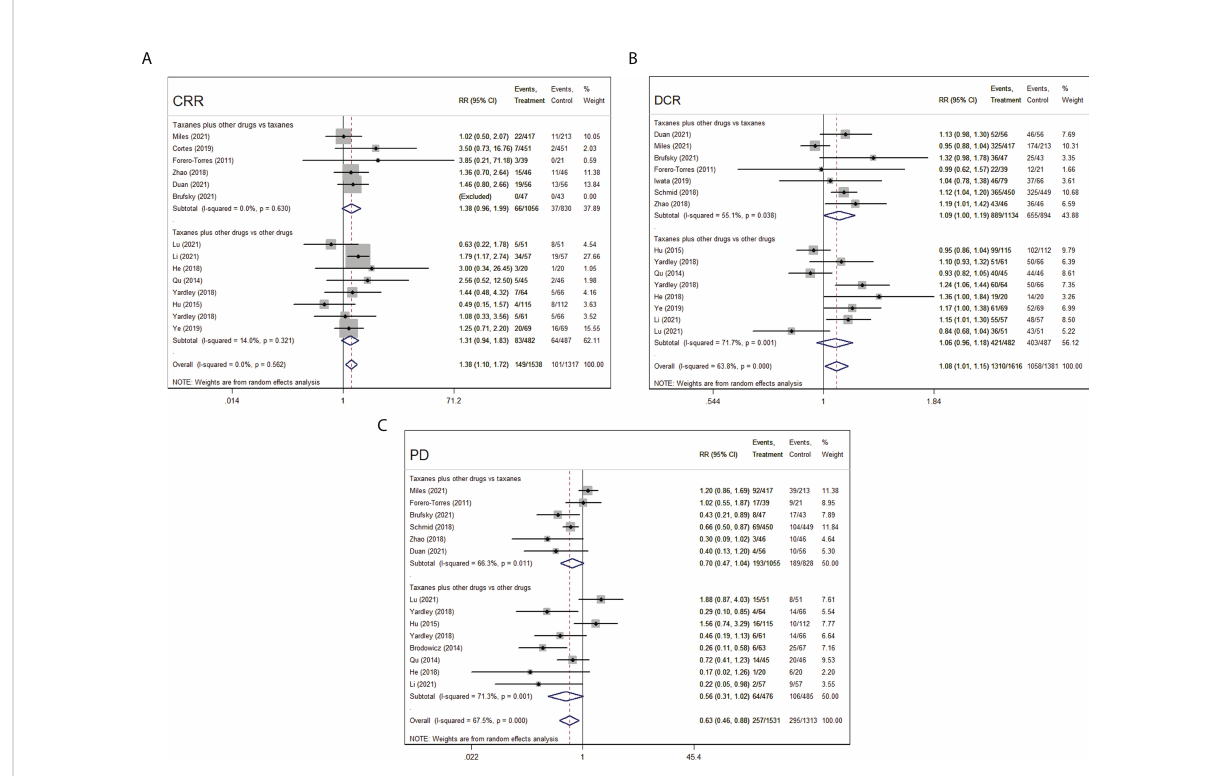
FIGURE 6 Forest plots of randomized controlled trials on taxanes combination therapy for secondary outcomes: CRR (A) , DCR (B) , and PD (C)